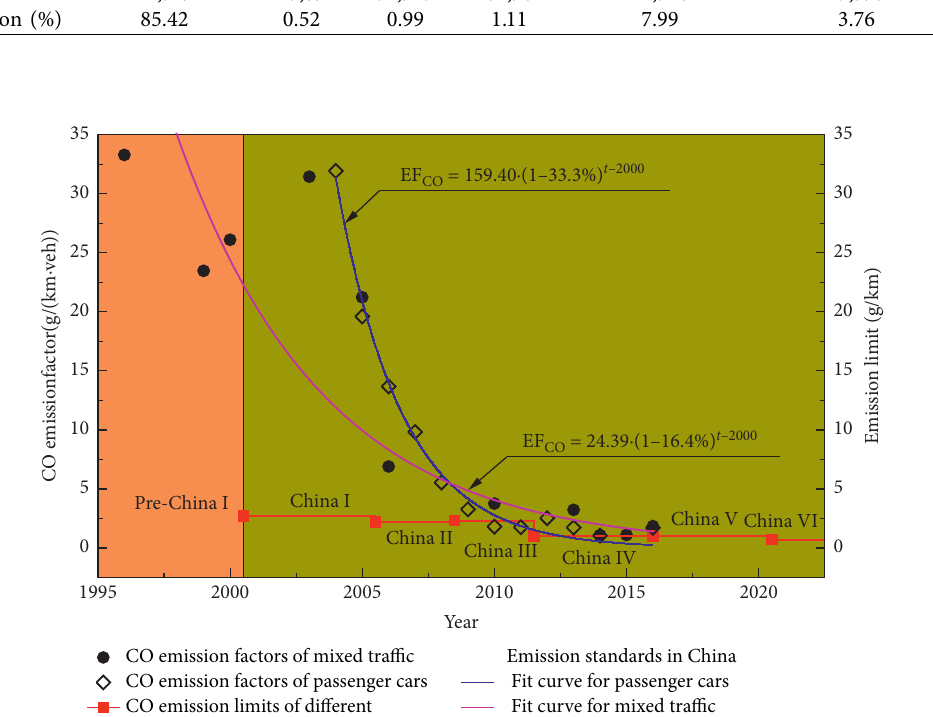
Figure 13: Changes in CO emission